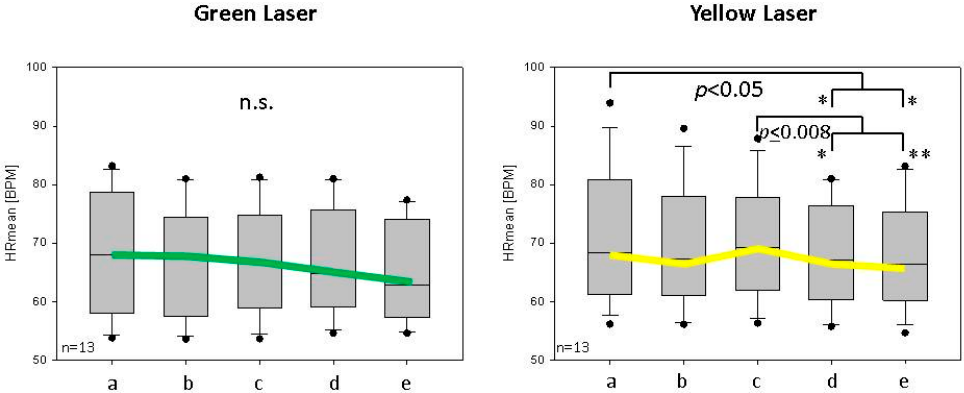
Figure 4. Box-plot of change in mean heart rate (HRmean in BPM (beats per minute)) values of all 13 female subjects before and after green and yellow laser acupuncture (phases a–e, see also Figure 3). The line in the box indicates the position of the median, the ends of the boxes define the 25th and 75th percentiles. The error bars show the 10th and 90th percentiles, and the dots represent “outliers”. Note the significance of the decrease in mean HR during (d) and after (e) yellow laser stimulation (* significant changes).